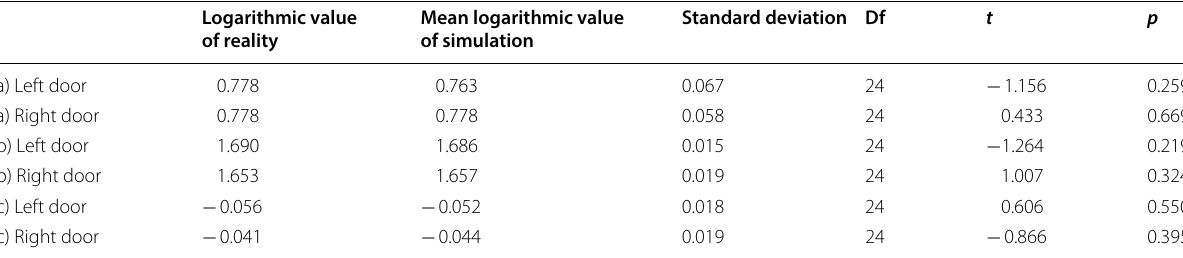
Table 2 Results of t-tests on three indicators